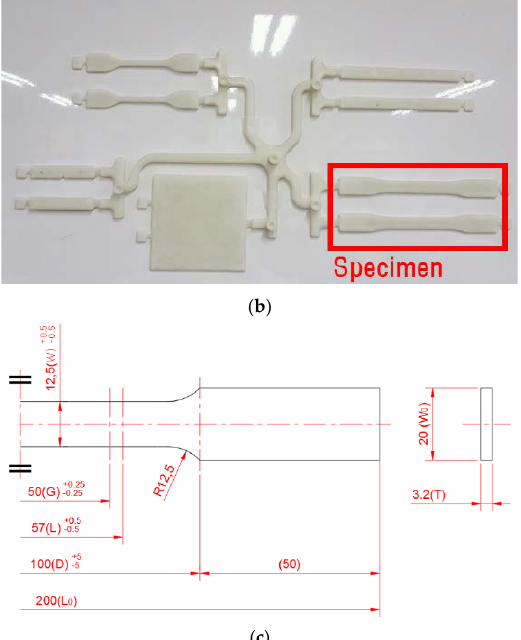
Figure 1. ASTM D638-14 specimen for tensile test: ( a ) schematic diagram of injection molding; ( b ) test specimen of glass fiber-reinforced polymer (GFRP); ( c ) specification of specimen for ASTM D638-14. Table 1 lists the Young’s modulus (E), Poisson’s ratio ( ν ), yield stress ( σ y ), and tensile strength ( σ UTS ) derived through tensile tests.